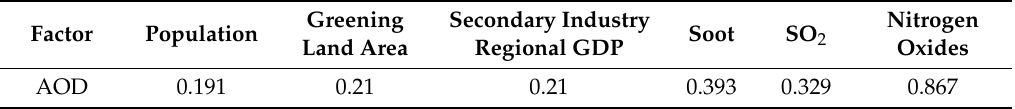
Table 2. Coefficient between AOD and Socio-economic